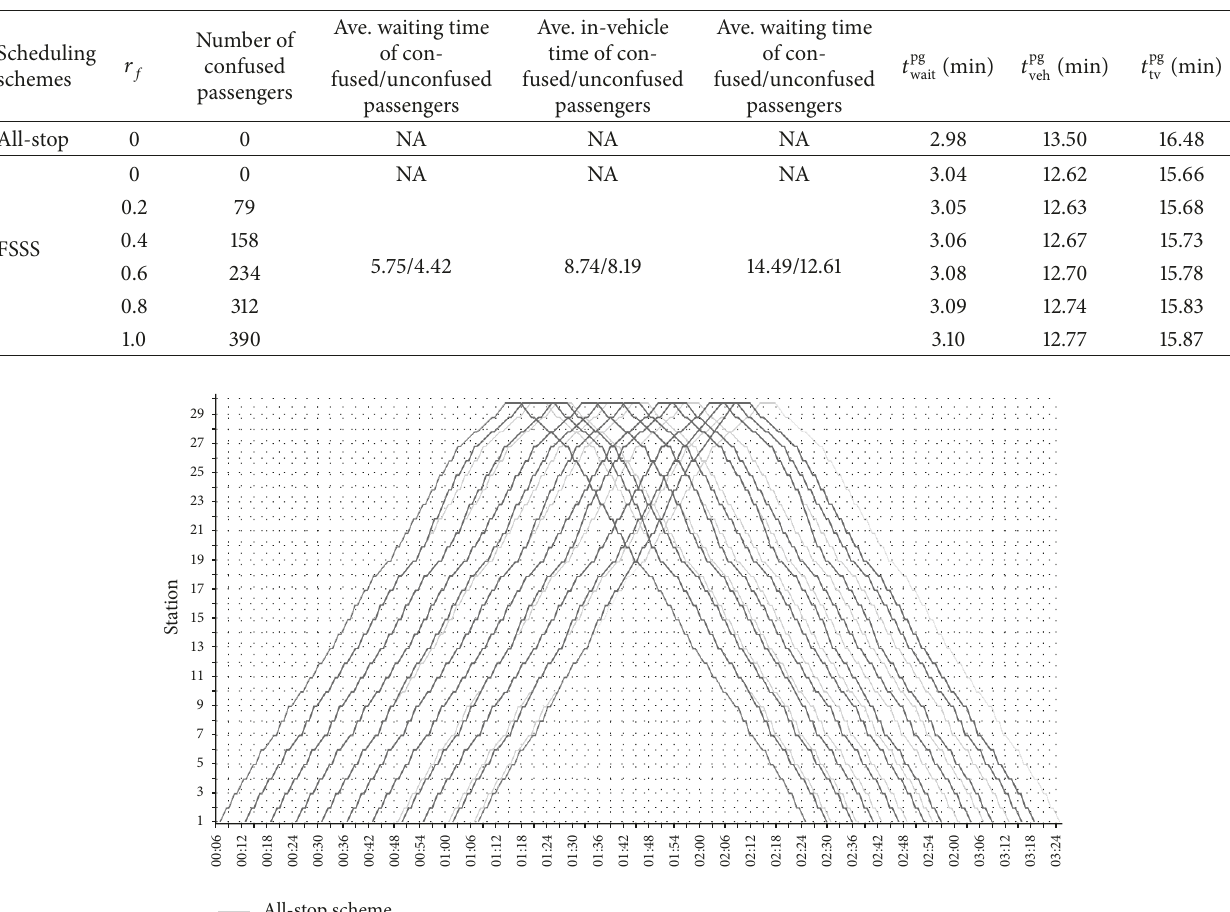
Table 5: Sensitive analysis of the passenger confusion rate.